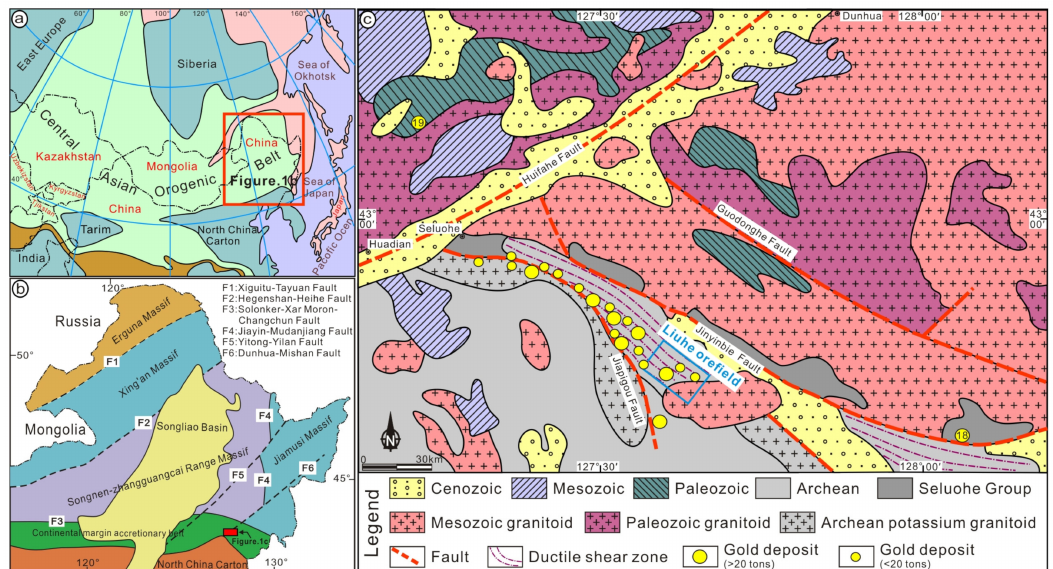
Figure 1. ( a ) General map showing the location of NE China, modified after Safonova and Santosh (2014) [22]; ( b ) tectonic sketch map of NE China (modified after Wu et al., 2011) [23]; ( c ) regional geological map of the Jiapigou gold ore belt, NE China. Showing the distribution of the major gold deposits (modified after Zeng et al., 2017)